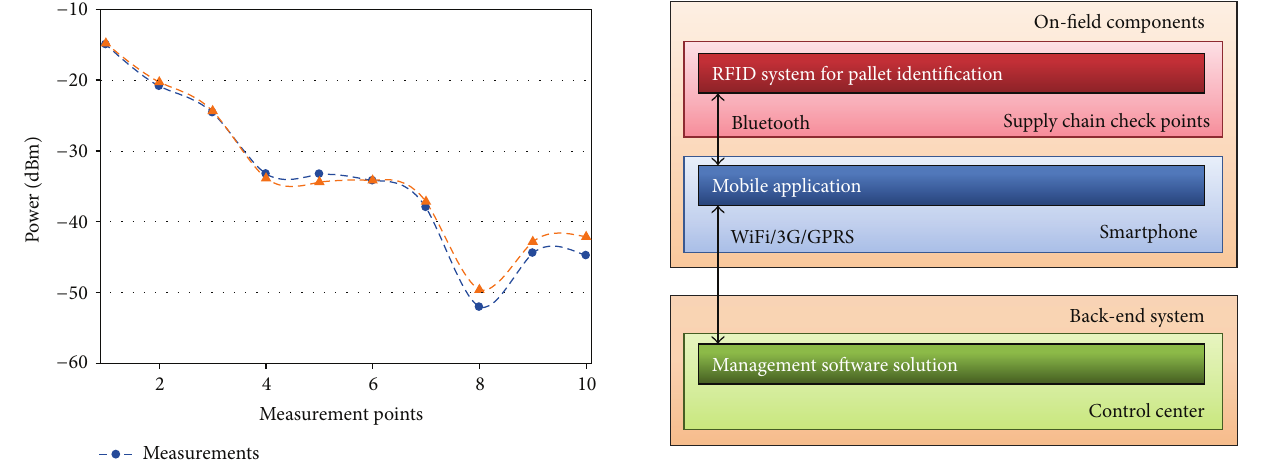
Figure 6: Interaction between the on-field and back-end System components of the proposed